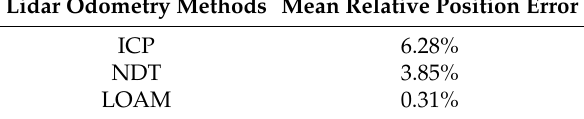
Table 4. Error comparison of three lidar odometry